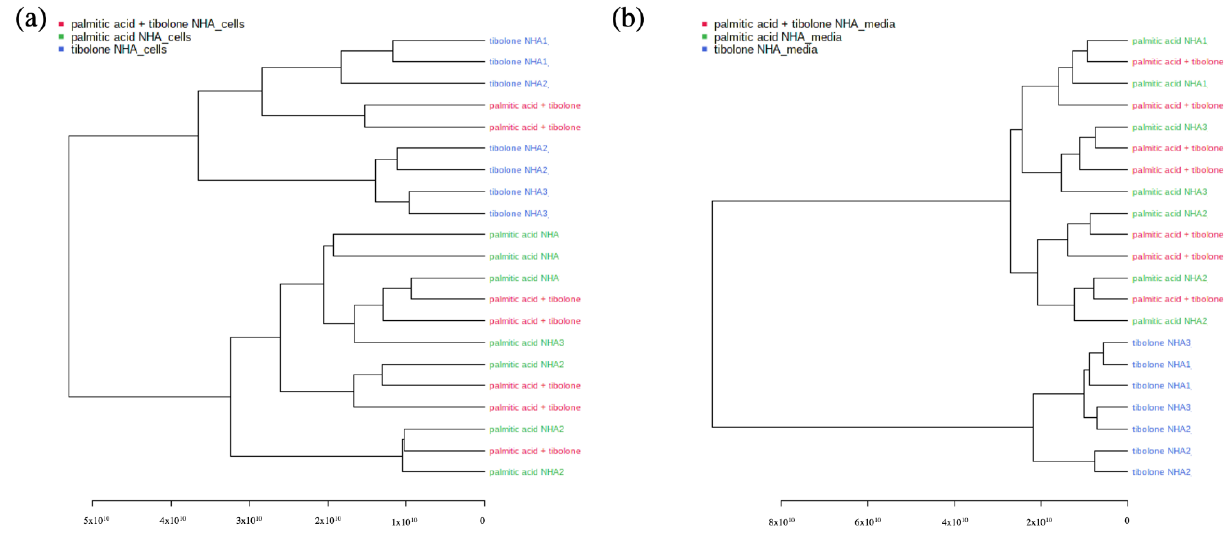
Figure 3. Dendrograms ( a ) (PA & T & PA + T)—Endometabolome ( b ) (PA & T & PA + T)— Exometabolome. The graph shows the complete separation between tibolone and the two remaining treatments (PA + T & PA) for the data corresponding to exometaboloma. However, this behavior is not evidenced in endometabolome, where there are two variables related to the treatments of palmitic acid + tibolone within the tibolone dataset. The dedrograms reflect the PCA clustering organization.